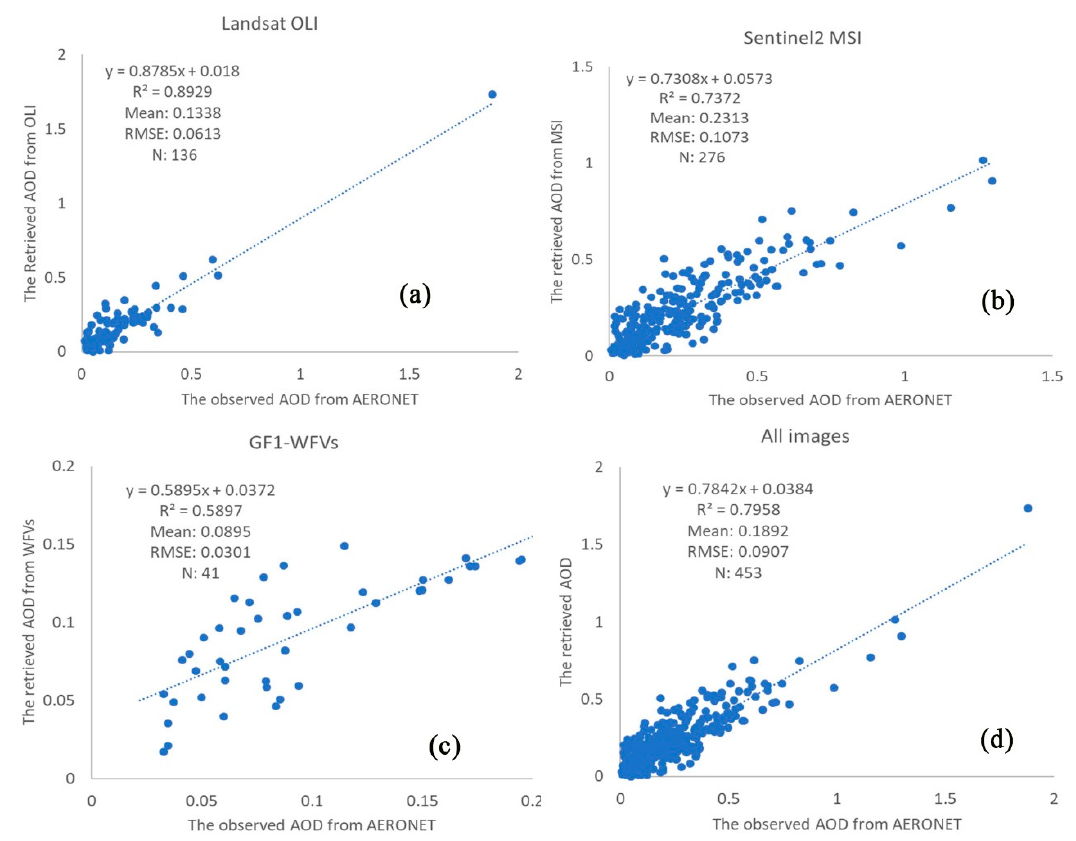
Figure 6. The validation of the retrieved AOD using 4 AERONET sites’ measurements around the world. The plots from the top left to the bottom right are the validation for ( a ) Landsat / OLI, ( b ) Sentinel2 / MSI, ( c ) GF-1 / WFV, and ( d ) all images from all the three sensors, respectively.